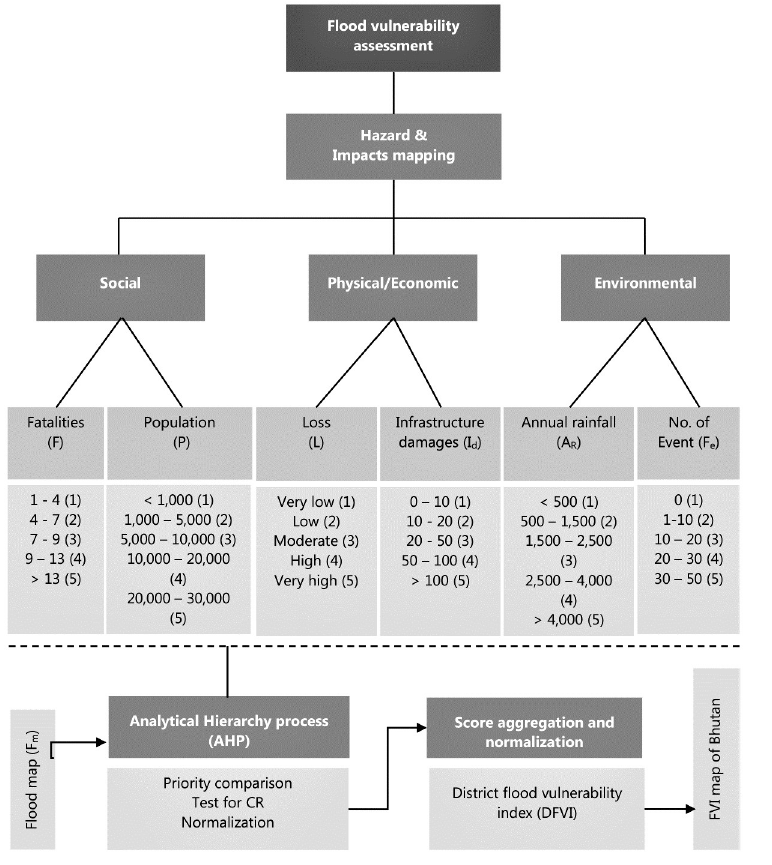
Fig 5. Methodological flowchart based on historical event-based indicators and application of AHP.